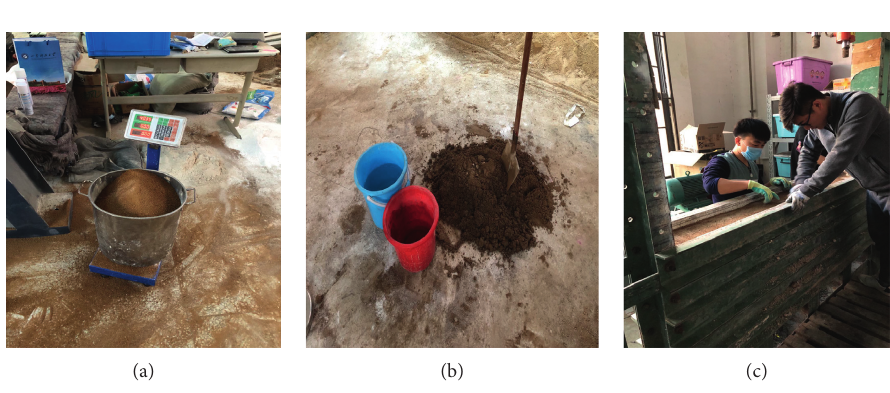
Figure 8: Model laying